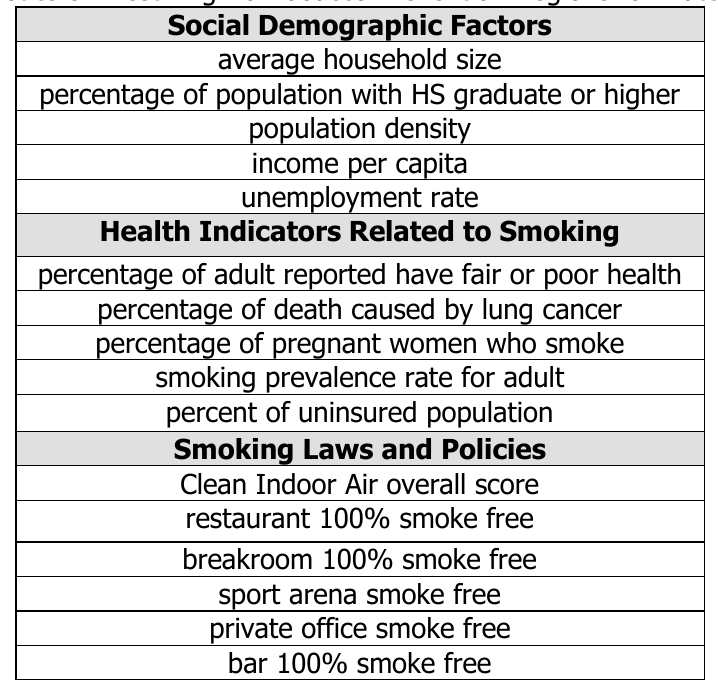
Characteristics of West Virginia Tobacco Prevention Regions for Matching